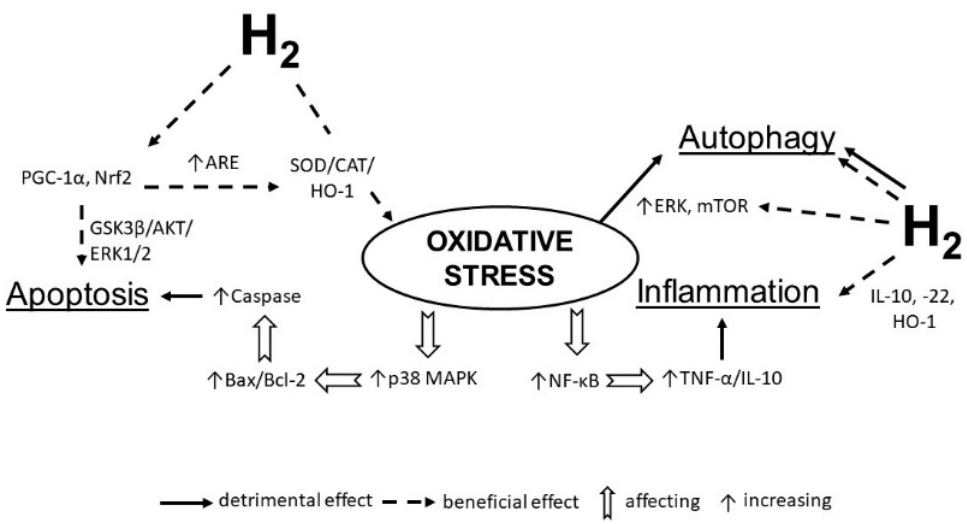
Figure Figure 2. Molecular hydrogen alleviates the negative impact of oxidative stress on the heart.